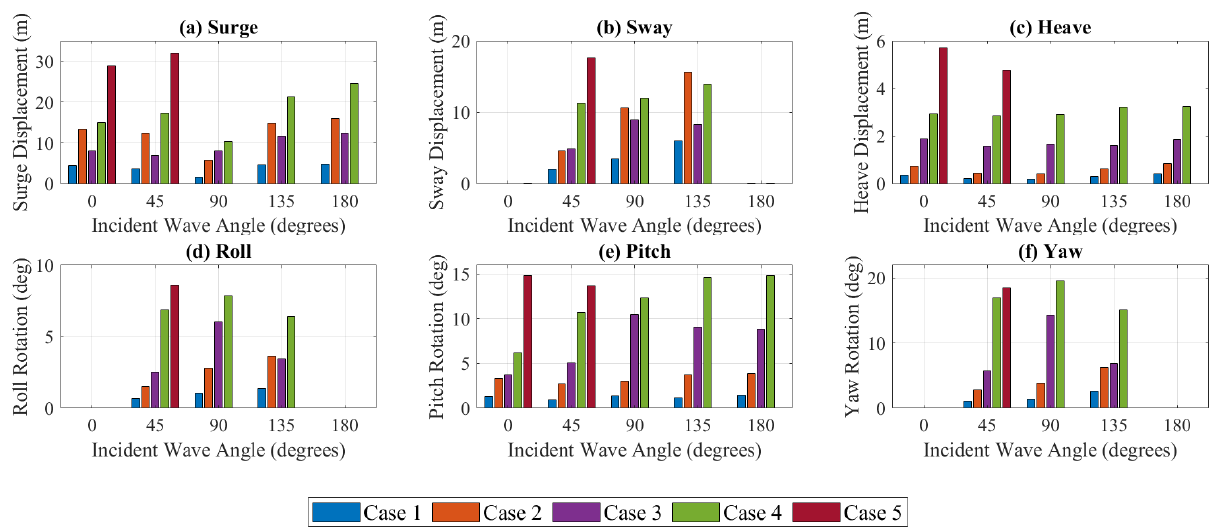
Figure 14. Significant values of the moored FOWC device motions in ( a ) surge, ( b ) sway, ( c ) heave, ( d ) roll, ( e ) pitch, and ( f ) yaw for all test cases (data withheld for Case 5 at incident waves angles of 90°, 135°, and 180°).